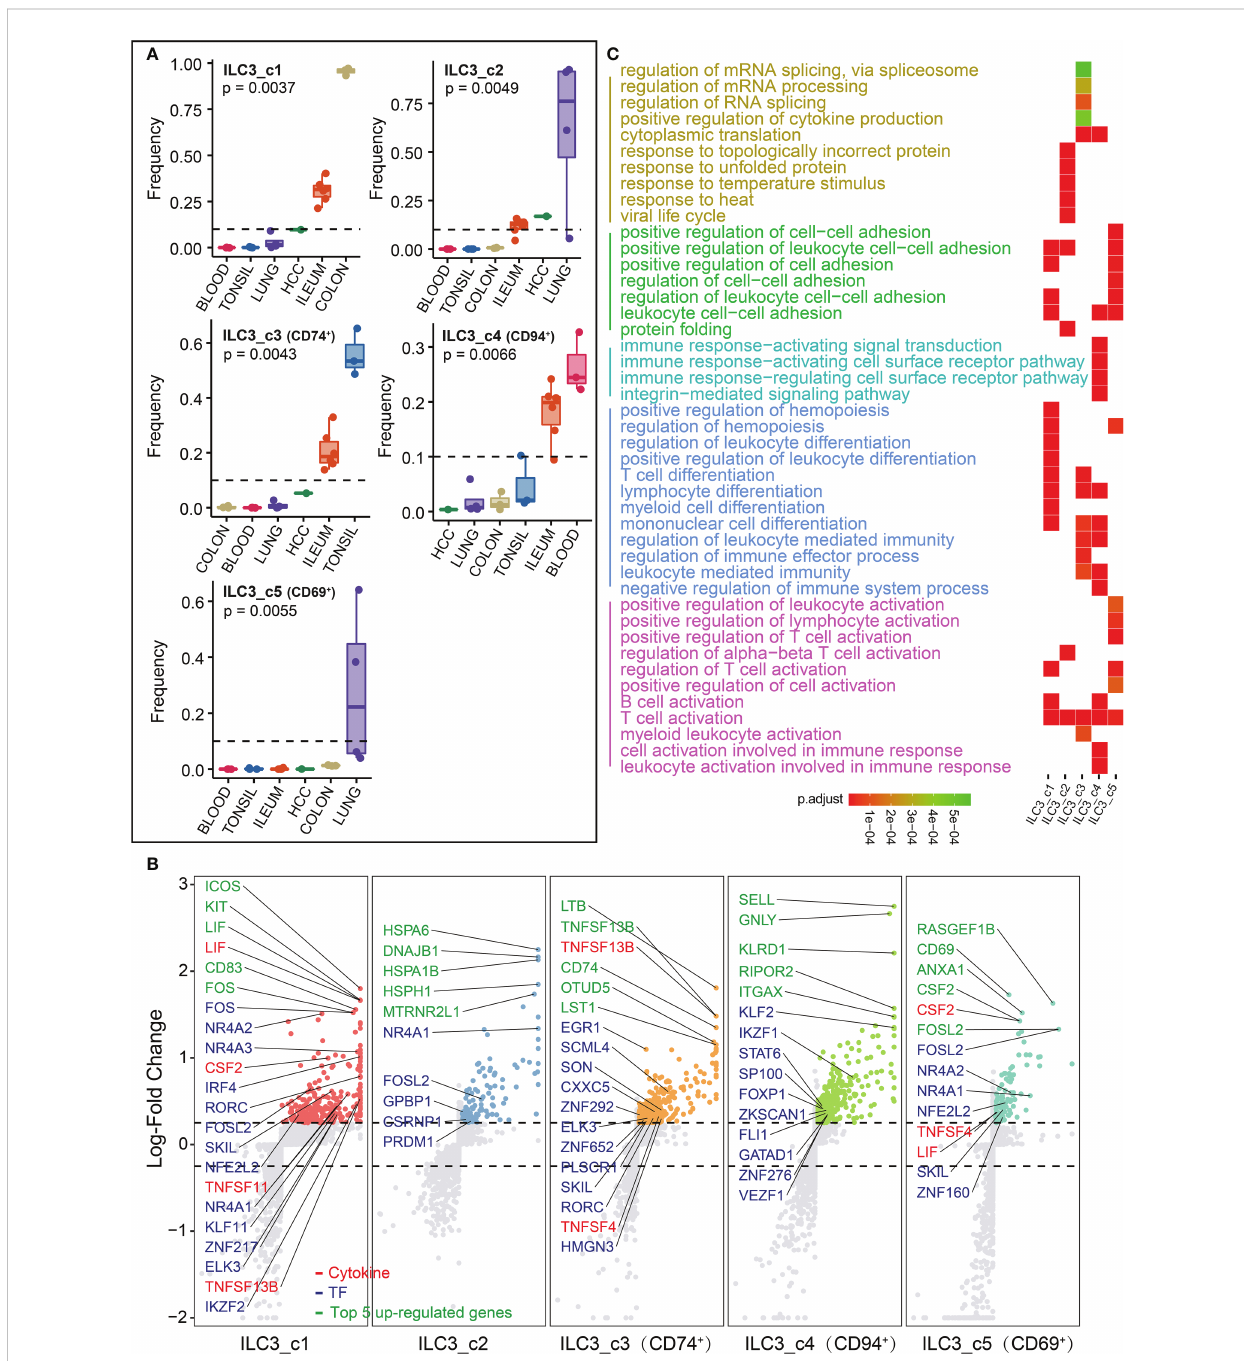
FIGURE 5 Characterization of ILC3s in different tissues. (A) Box plots showing the frequencies of four ILC3 subsets (divided by the total CD127 + ILC number) in lung, colon, ileum, tonsil, blood and HCC. P values were calculated from Kruskal-Wallis test. (B) Differential gene expression analysis showing up- and down-regulated transcripts across six ILC3 subsets. (C) Functional enrichment analysis showing top 15 GO terms in each ILC3 subset of biological